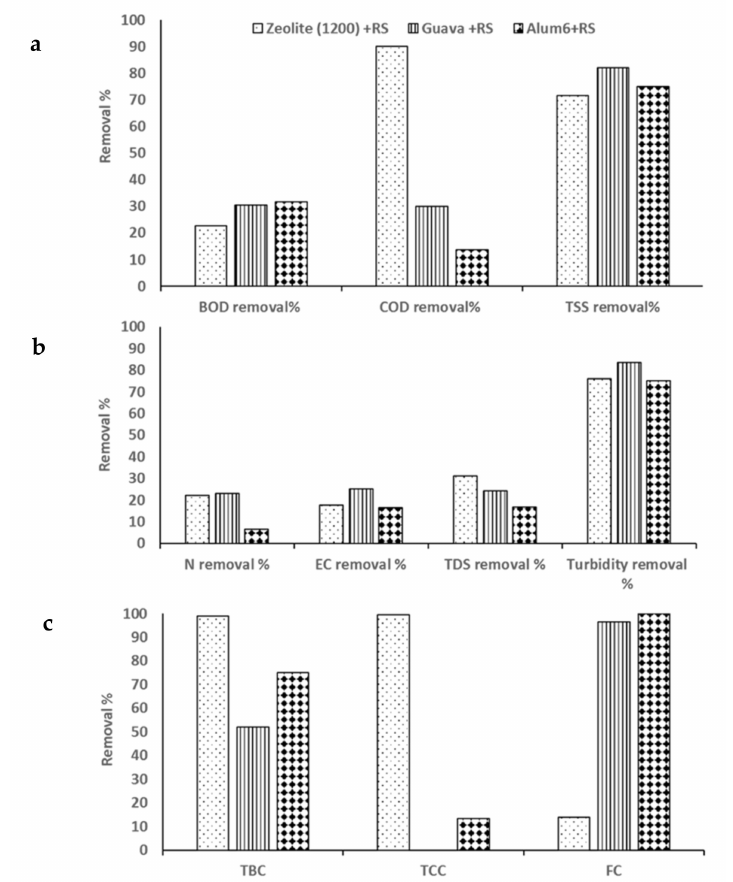
Figure 6. Contaminant removal efficiencies by the most effective dose of coagulants followed by filtration with physically treated rice straw (RS): Z 1200 mg; GLP 1000 mg; alum 6000 mg: ( a ) Chemical oxygen demand (COD), biological oxygen demand (BOD), and total suspended solids (TSS); ( b ) Total phosphorus (TP), nitrogen removal (N), electric conductivity (EC), and total dissolved solids (TDS); ( c ) Total bacterial count (TBC), total coliform count (TCC), and fecal coliform